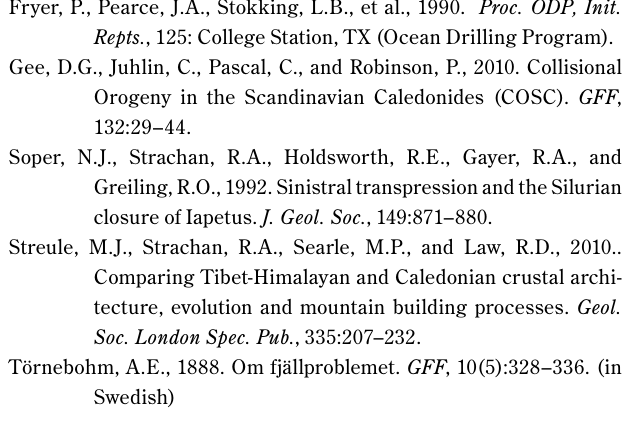
Fig. 3: Geological map, copyright Geological Survey of Sweden